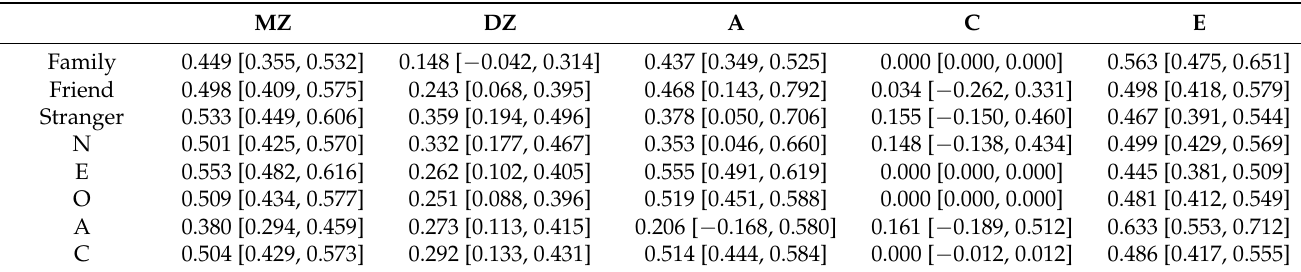
Table 2. Twin intra-class correlations and estimated contributions of additive genetic (A), shared environment (C) and non-shared environment (E).